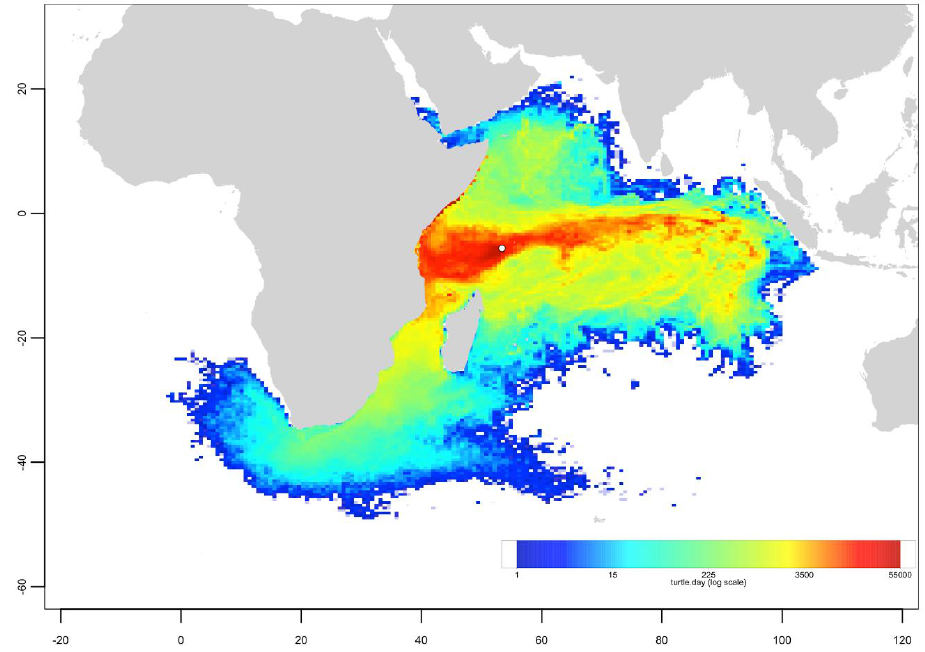
Figure A3. Amirantes group dispersal map. One-year long trajectories of 10,000 particles released from a 0.25 ◦ × 0.25 ◦ areas central to the Amirantes group (with circle) from 2002 to 2006 (for a total of 50,000 particles). The color indicates the density of particles in the number of turtles per day (log